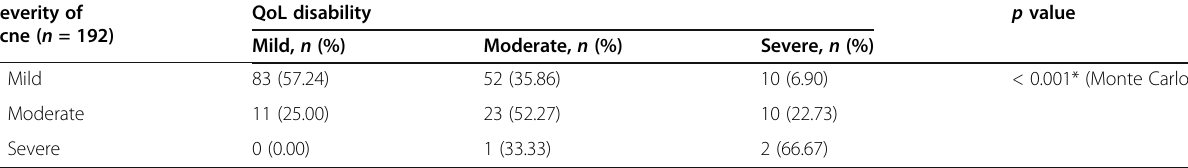
Table 3 Severity of acne and quality of life disability in secondary school adolescents, Alexandria, Egypt, 2016 Severity of acne ( n = 192)